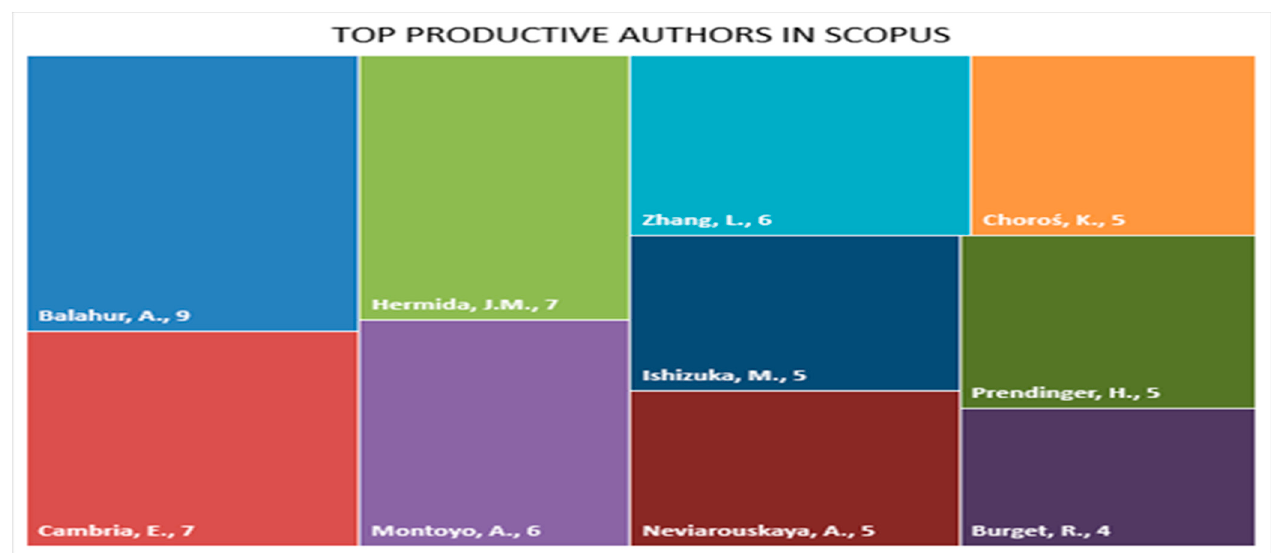
Figure 11. Top Productive Authors on Scopus.